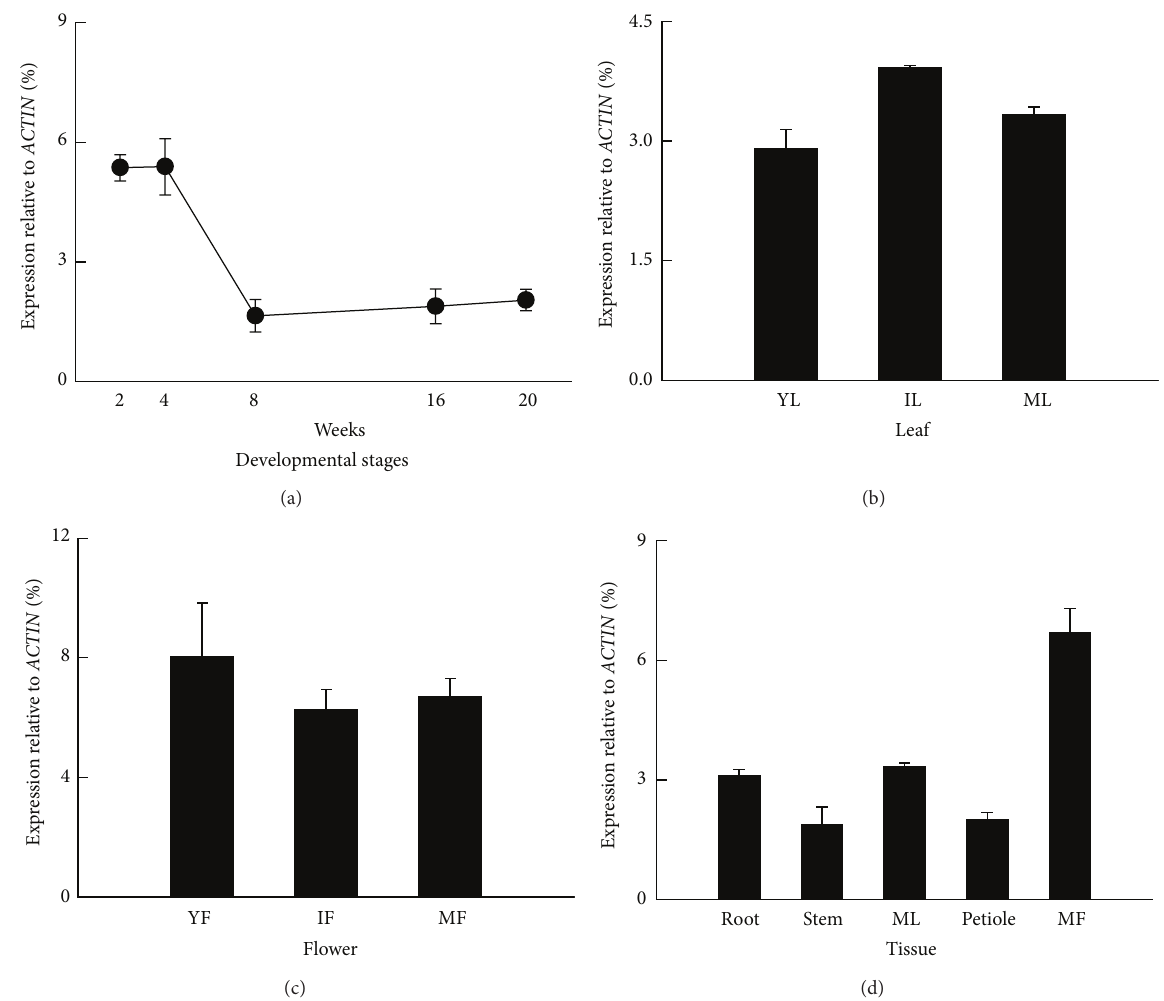
Figure 5: Transcript expression patterns of HcCCR2 in various tissues and organs during developmental stages. Relative transcript levels were measured using QPCR and ACTIN transcript were used as internal control. The transcript levels of kenaf CCR ortholog were adjusted after deduction of the control transcript level: (a) during stem development (2, 4, 8, 16, and 20 weeks after sowing), (b) during leaf development (YL, young leaf; IL, immature leaf; ML, mature leaf), (c) during flower development (YF, young flower; IF, immature flower; MF, mature flower), and (d) expression pattern in various tissues and organs from 16-week-old kenaf plants. Bars show means ± standard error of 3 biological